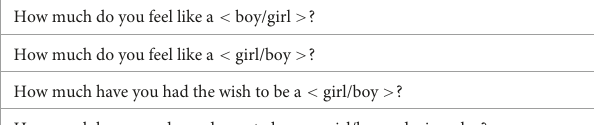
TABLE 2 Multi-dimensional assessment of